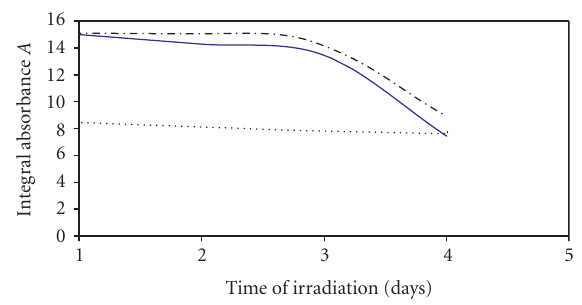
Figure 6: The changes of integral absorbance of Amide II band in FTIR spectra during solar irradiation of collagen (solid curve), col- lagen/PVA (dotted curve), and collagen/PVP films (dashed curve), key to time and dose of solar radiation in Table